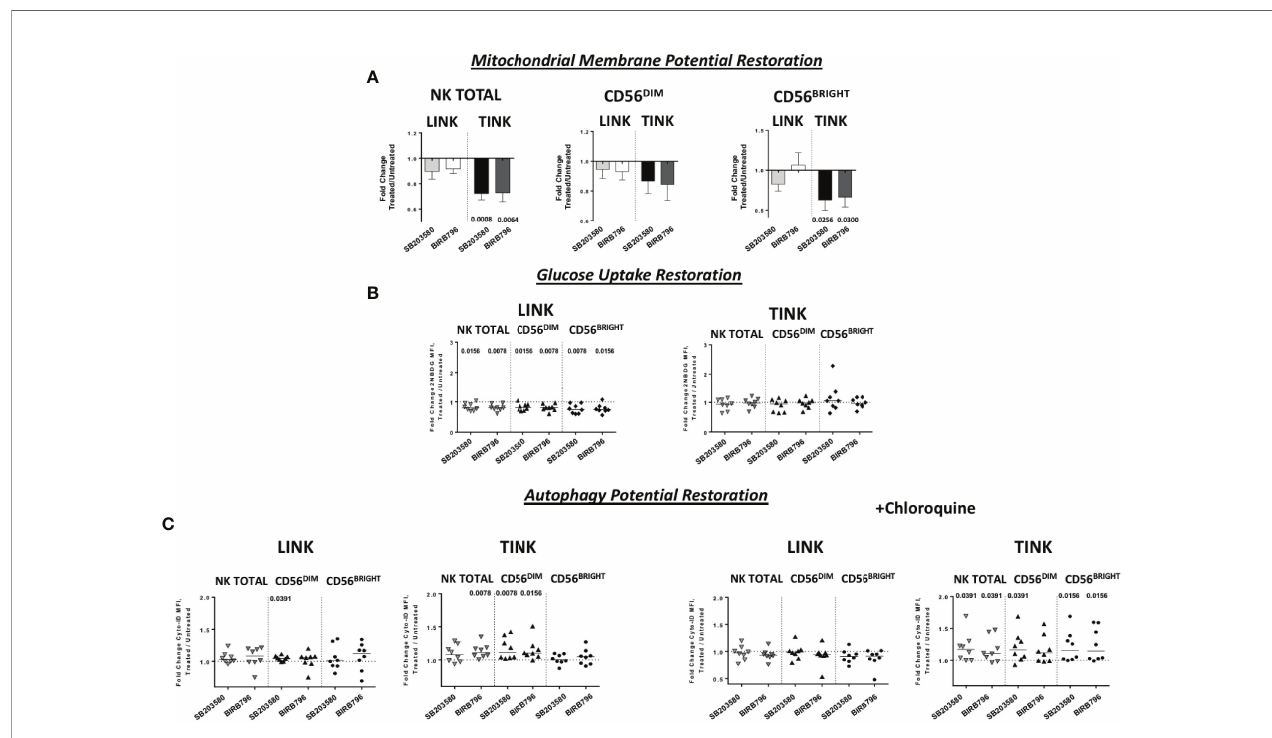
FIGURE 7 | Metabolic restoration of HCC ( n = 8) and non-tumorous liver-in fi ltrating NK cells ( n = 8). IL-12 + IL-18 overnight stimulation with or without speci fi c p38 inhibitors was followed by fl ow cytometry determination of JC-1 (A) 2-NBDG (B) and Cyto-ID (with and without chloroquine) (C) . Data are presented as the ratio between the metabolic values in inhibitor-treated vs . untreated NK cells from liver and tumor counterparts (fold change). Horizontal lines represent median values. Statistics by Wilcoxon signed-rank